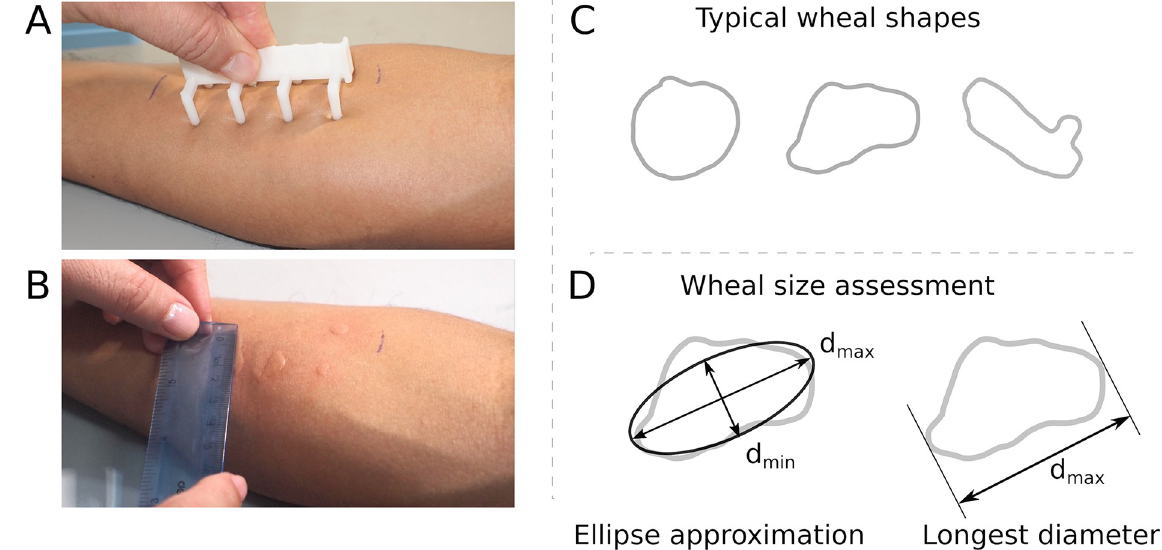
Fig 1. (A) The physician performs the SPTs with a disposable multi-test on the surface of the forearm. (B) After 15 minutes, the physician measures the skin reactions or wheals using a ruler. (C) Typical shapes of wheals, from regular to irregular shape with pseudopod. (D) The wheal size assessment is approximated as an ellipse or by measuring the longest